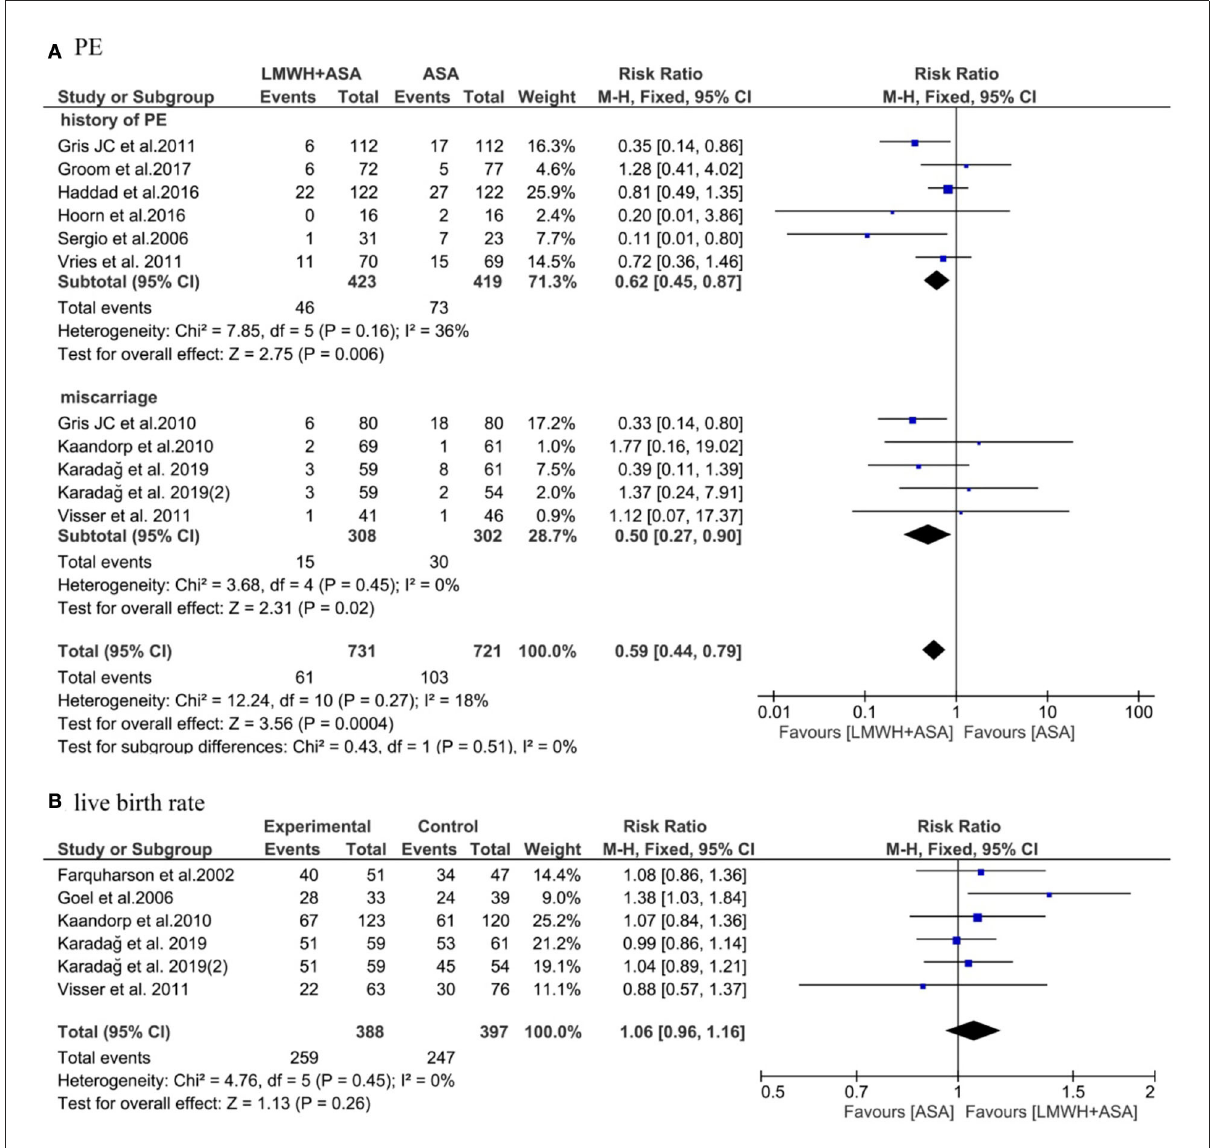
FIGURE3 Meta-analysis of (A) PE and (B) live birth